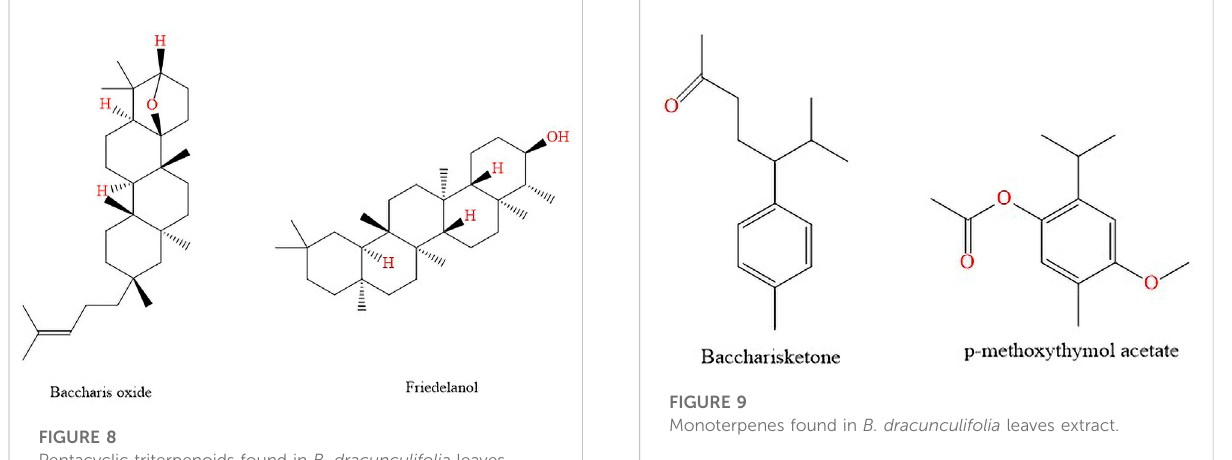
FIGURE 8 Pentacyclic triterpenoids found in B. dracunculifolia leaves and roots extract.